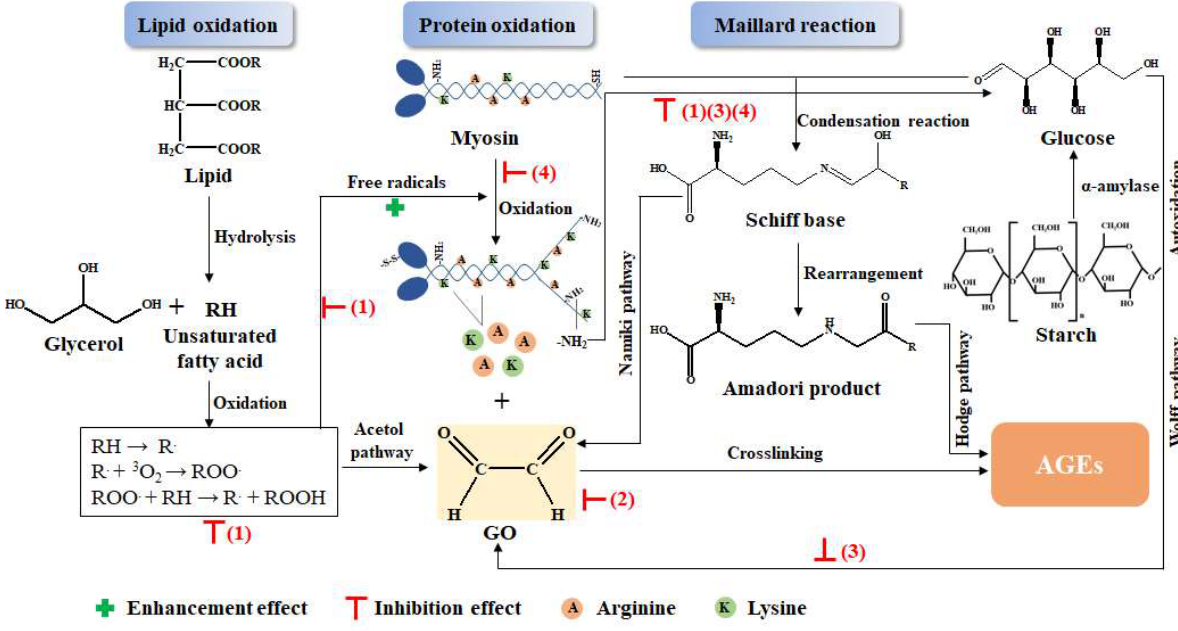
Figure 8. Possible mechanism for the inhibitory effect of the GLP on the